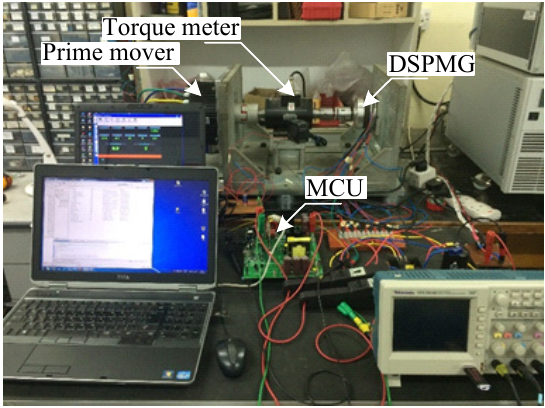
Figure 10. Experimental system with the new estimator control method. MCU: microcontroller unit; DSPMG: double-stator permanent magnet generator.